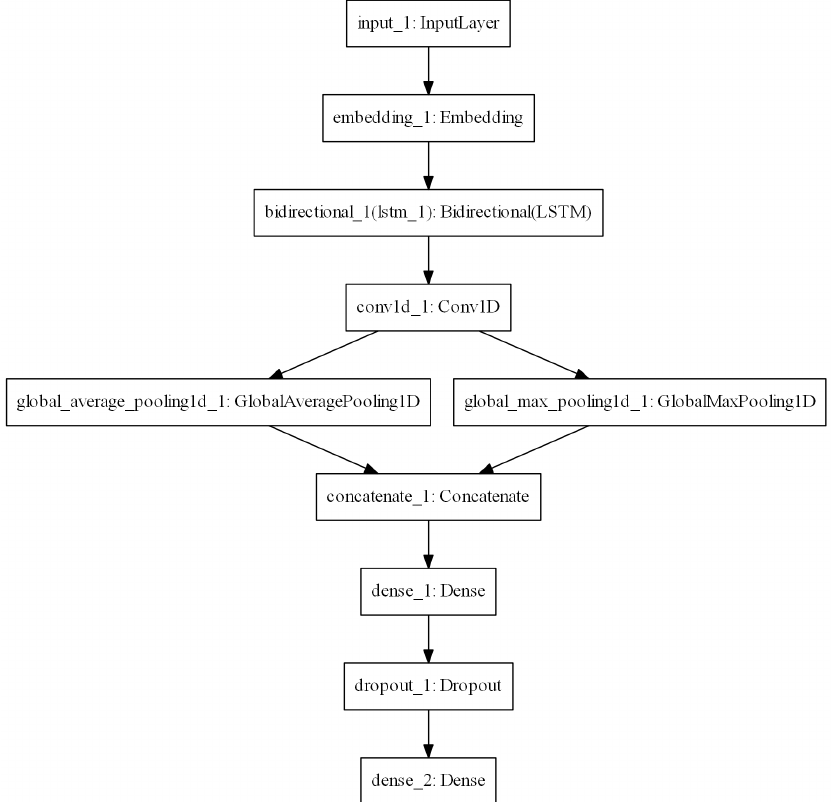
Figure 8. Architecture of the composed BiLSTM + CNN model for multi-label